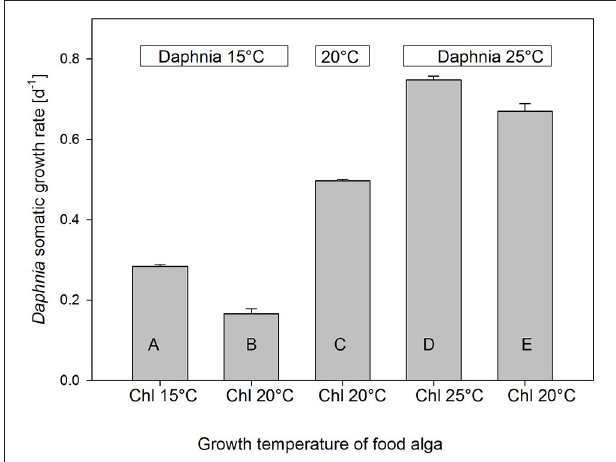
FIGURE 4 | Mean ( + SE, n = 3) juvenile somatic growth rates of D. magna grown at 15, 20, or 25 ◦ C on C. klinobasis grown in continuous cultures at 15, 20, or 25 ◦ C. Different letters indicate significant differences between treatments (Tukey’s HSD after one-way ANOVA). Daphnia growth rate increased with ambient temperature; when the alga was grown at the same temperature as Daphnia , it supported higher growth rates than C. klinobasis grown at 20 ◦